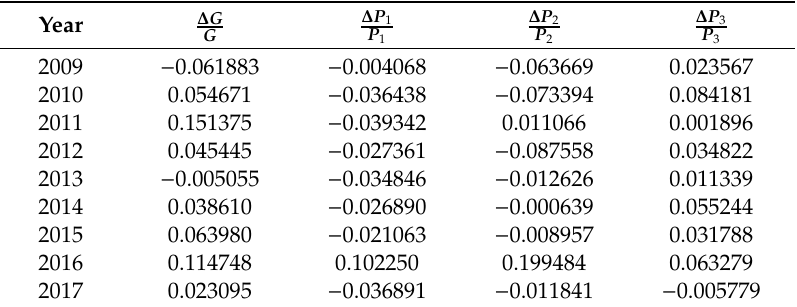
Table 3. Rate of change in each index value in each